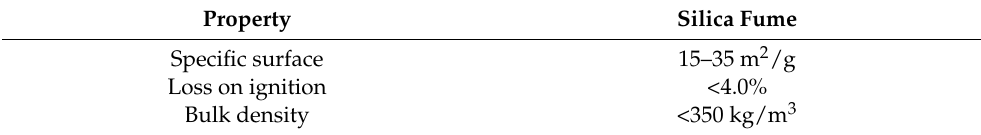
Table 3. Physical Properties of Silica Fume.